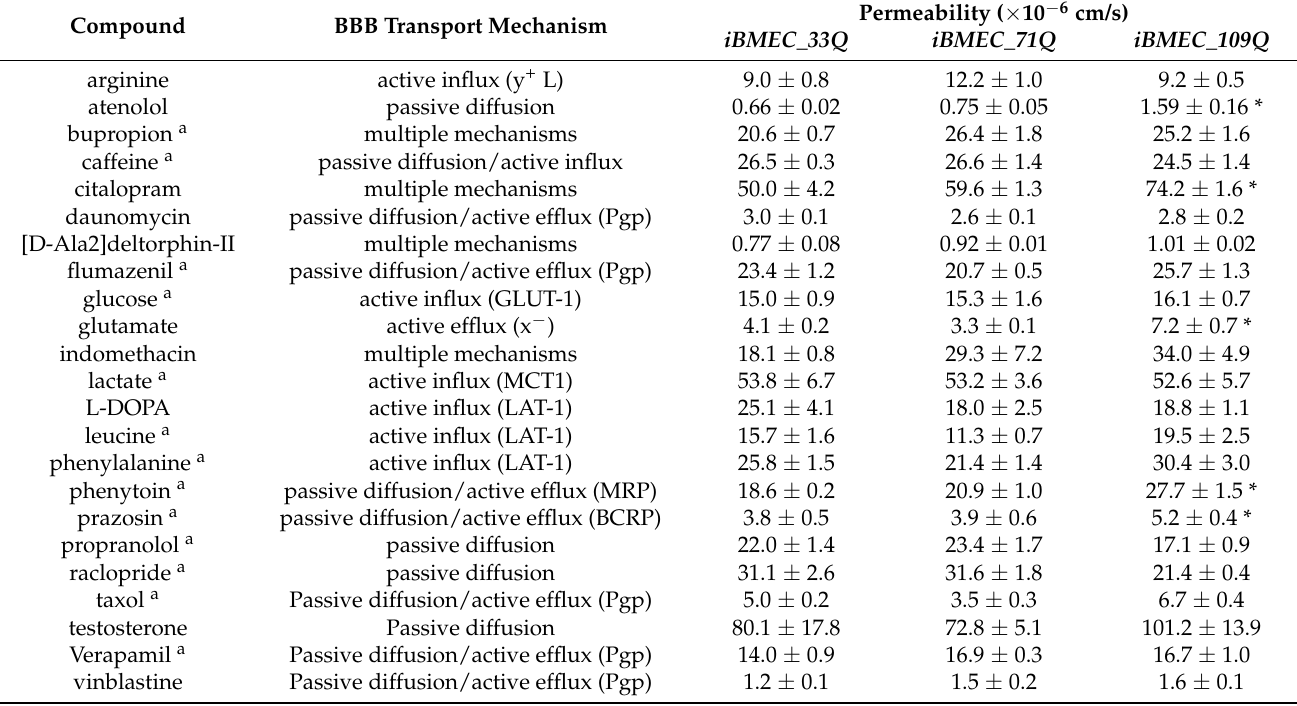
Table 1. Permeability of commercially available compounds with different transport mechanisms.